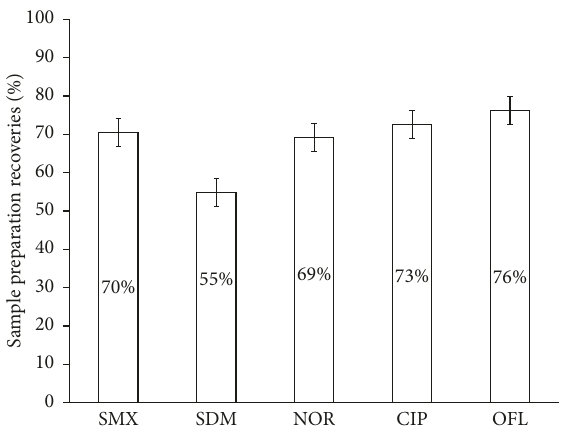
Figure 4: Average sample preparation recoveries for 5 antimicro- bials from carrot roots using LE and SPE. Matrix: carrot roots. Error bars are 2 times standard deviation. CIP, ciprofloxacin; NOR, norfloxacin; OFL, ofloxacin; SDM, sulfadimethoxine; SMX,